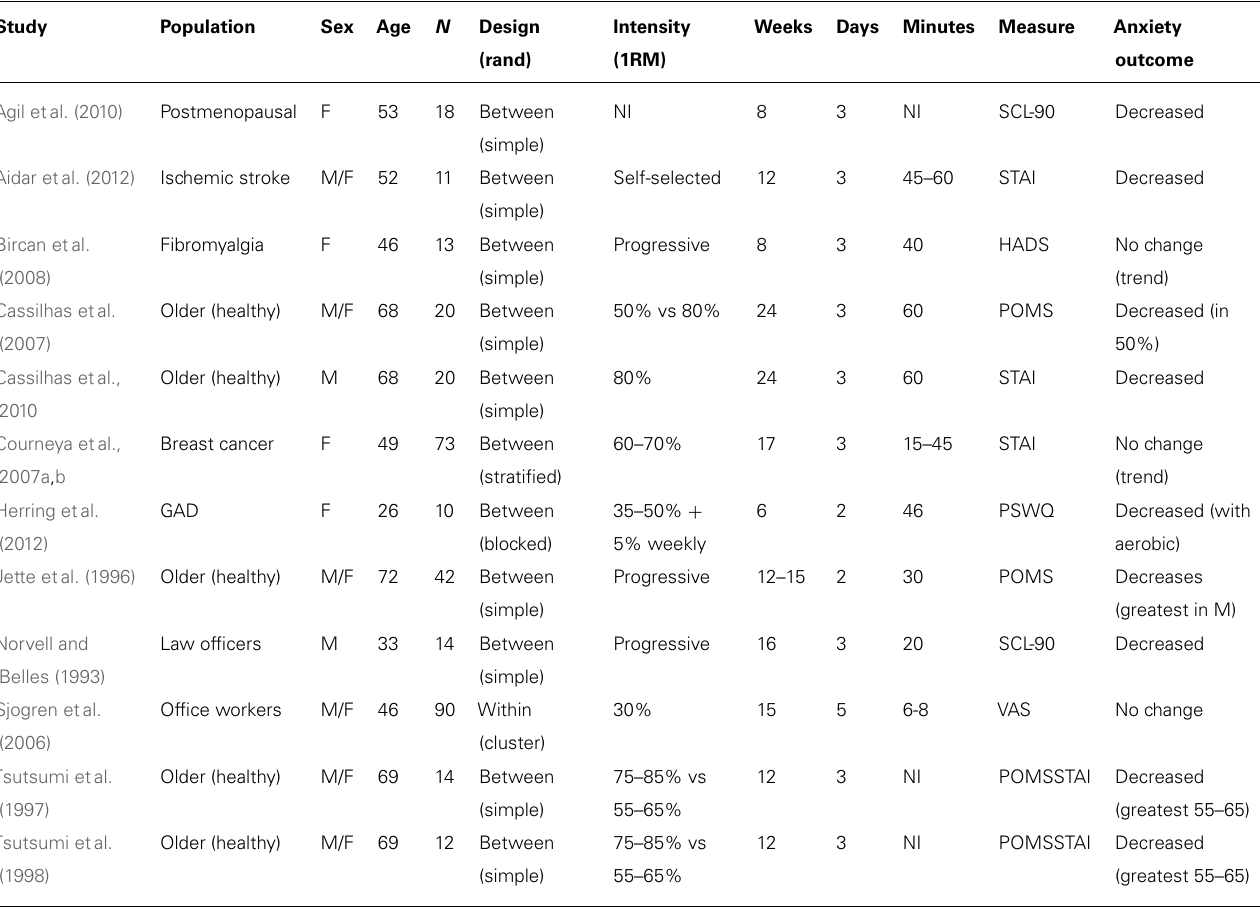
Table 2 |The effects of long-term resistance exercise on anxiety measures.